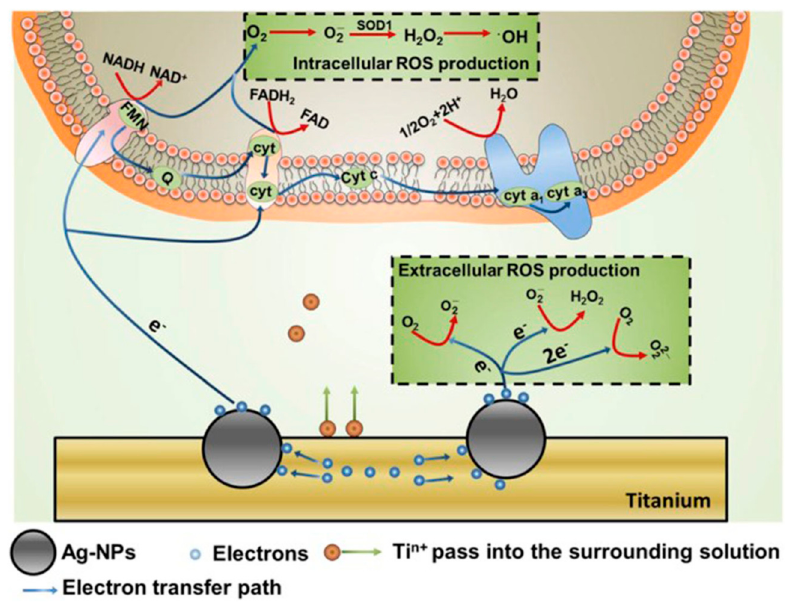
Figure 5. Production of ROS outside and inside bacterial cells. Reproduced with permission from Reference [80]. Copyright 2017, Elsevier.